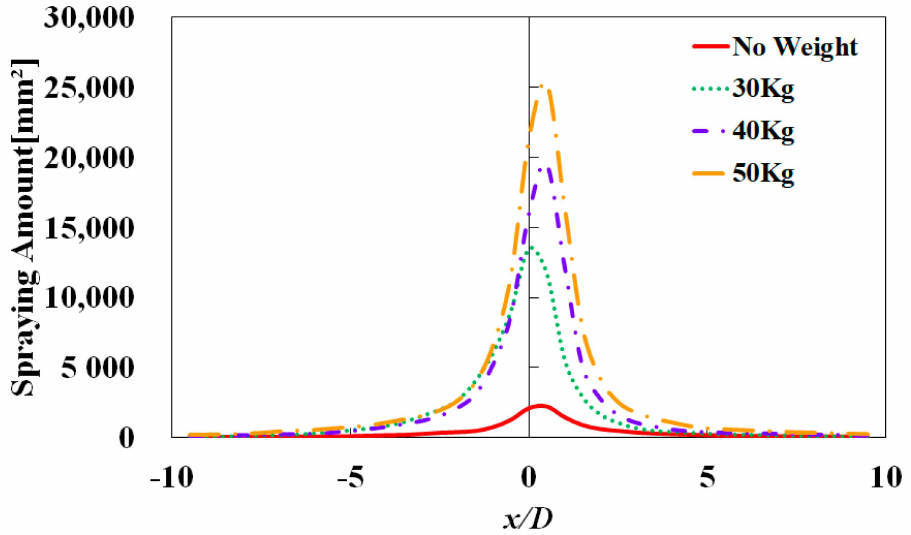
Figure 9. Line profile of spraying amount of the developed nozzle at z = 5.